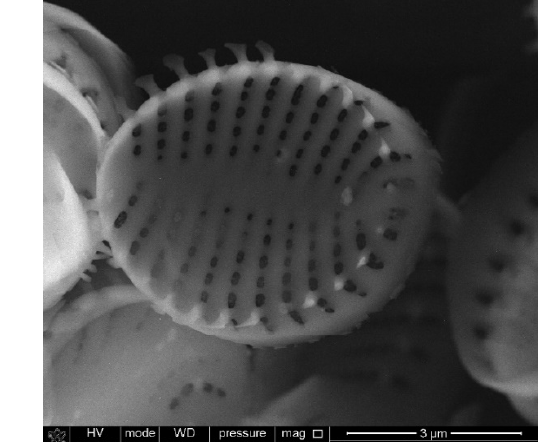
Figure 1. SEM images of the diatomaceous biosilica.